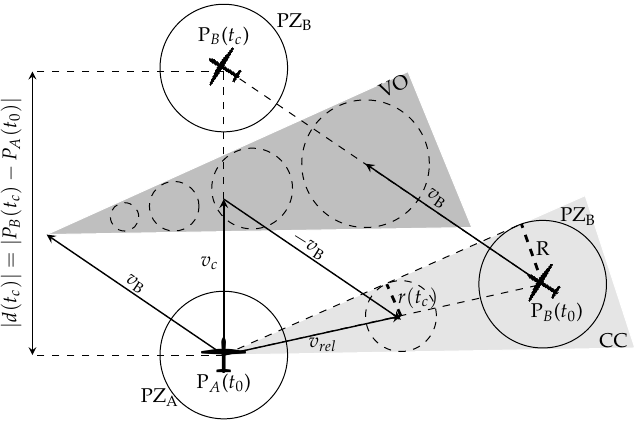
Figure 6. Representation of a velocity obstacle (VO) imposed by intruder B, and the relationship between a circular velocity vector set and the protected zone (PZ) [16]. By adding the intruder’s velocity, the collision cone (CC) is translated forming the intruder’s VO.